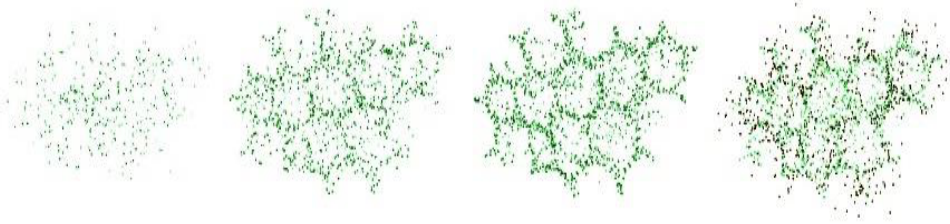
Figure 10. Jenny Johnstone. Green network forming, which could be oxygen or carbon, 2020.